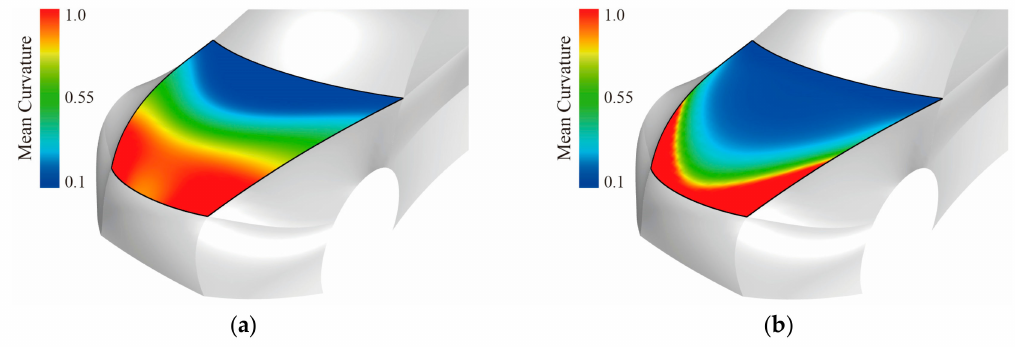
Figure 7. E ff ect of altering the shape parameters on hood surface: ( a ) α u , γ u , α v , γ v = 1; ( b ) α u , γ u , α v , γ = − v